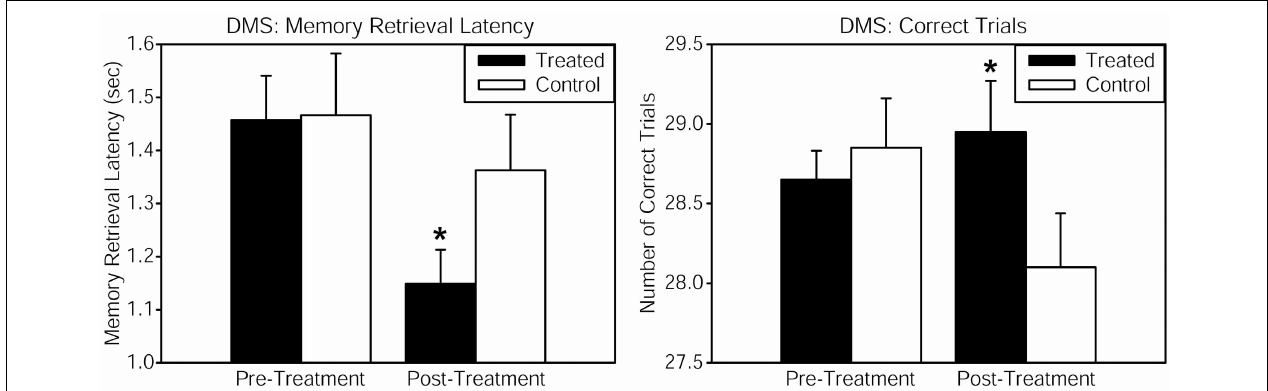
FIGURE 1 | Cognitive performance in the delayed match-to-sample (DMS) memory task was improved after transcranial infrared stimulation to the right forehead. The DMS task involves presentation of a visual stimulus (grid pattern) on a screen. Then the stimulus disappears, and the participant must remember the stimulus through a delay. Then two choices appear, and the participant must decide which of these two is identical to the previous stimulus (the “match”). Treated subjects showed faster memory retrieval (left panel) and increased number of correct trials (right panel) out of 30 trials when attempting to choose the correct grid